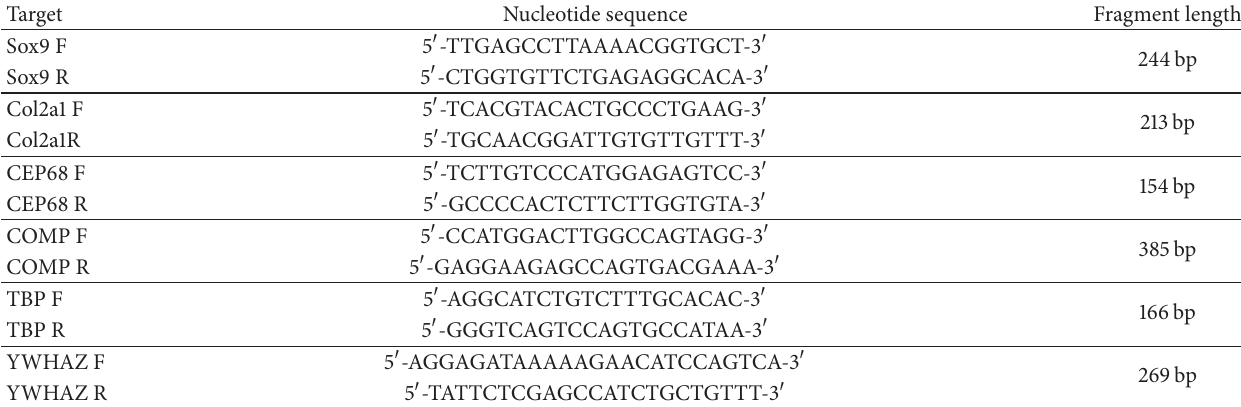
Table 1: Primer sequences used to identify early and late chondrogenic